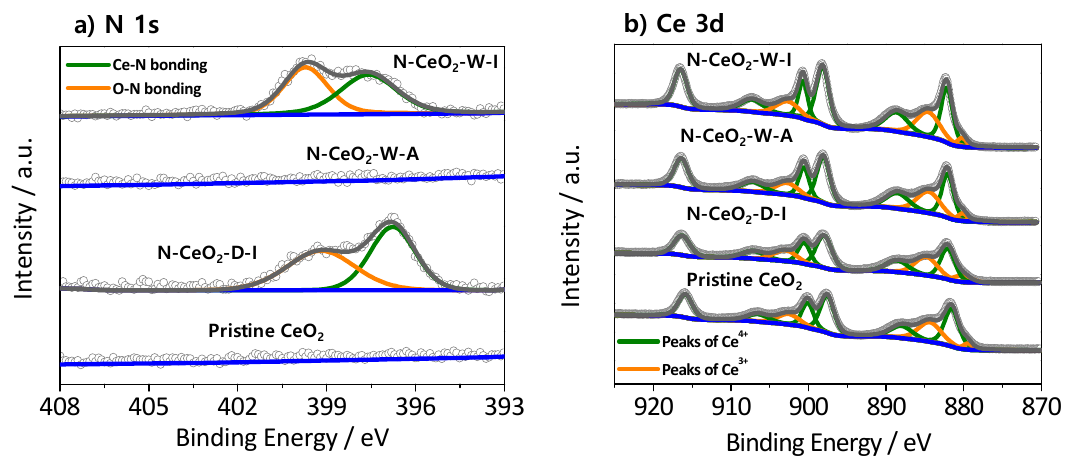
Figure 6. XPS spectra of the pristine CeO 2 and the N-doped CeO 2 NPs: ( a ) N 1s, ( b ) Ce 3d binding energy level. Table 4. Atomic content and the relative Ce concentration on the pristine CeO 2 and the N-doped CeO 2 NPs.